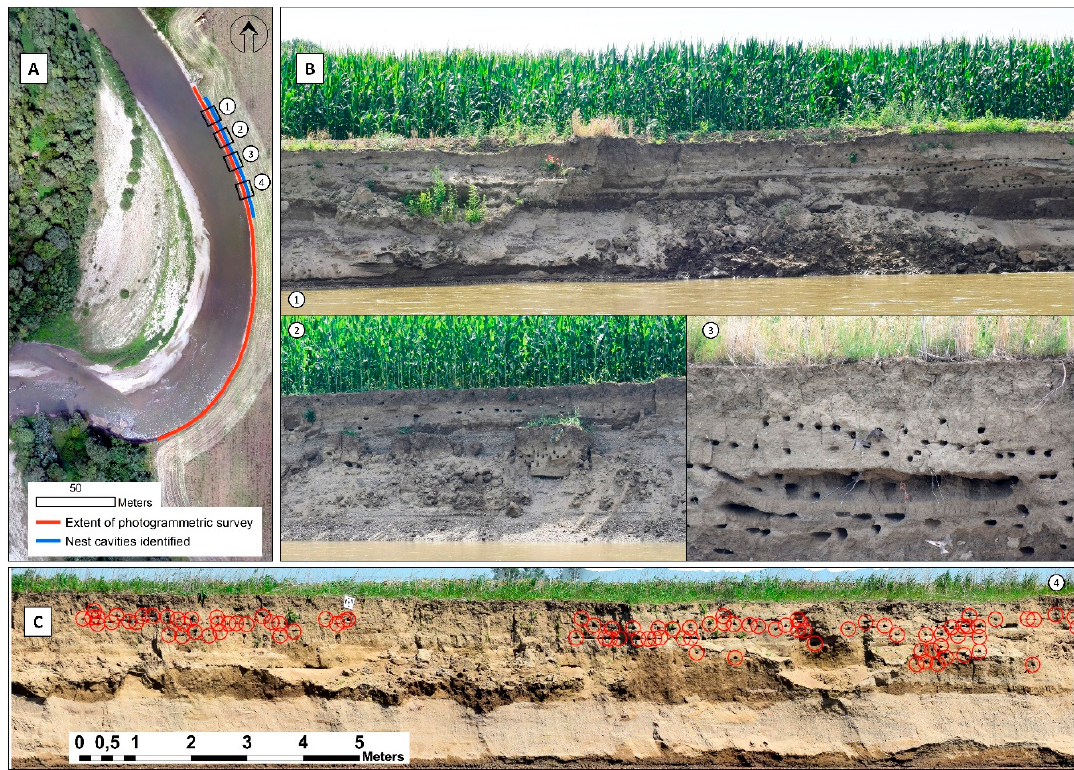
Figure 11. Nest cavities along the eroding river banks of Sajó River at the study area. ( A ) The overview of the cavities; ( B ) Examples of cavities along the recently eroded slump blocks; ( C ) Red circles indicates the cavities identified on one part of the mosaic.